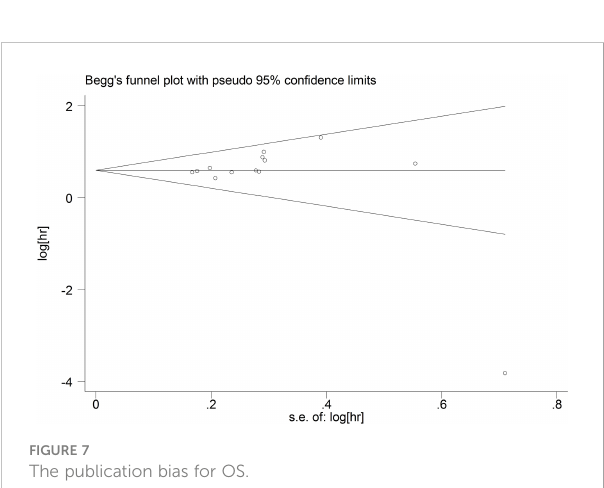
FIGURE 6 Sensitivity analysis for DFS/PFS/RFS.